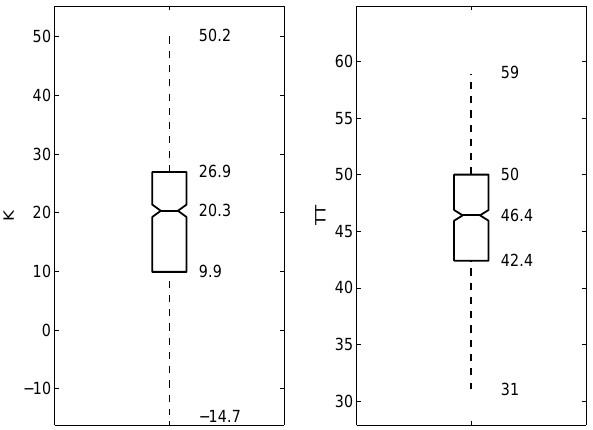
Fig. 1. The distribution of the values of the K and TT indices of all cases with non-zero value of CAPE.